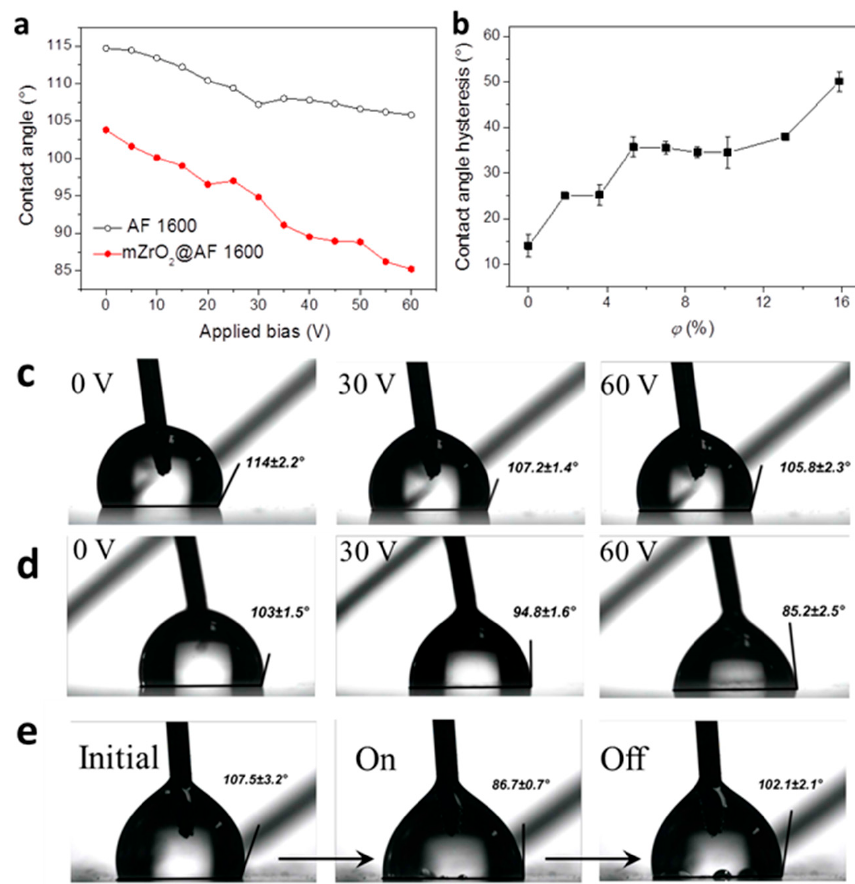
Figure 7. ( a ) Contact angles of the two films under applied DC electric field; ( b ) Contact angle hysteresis of the nanocomposite film with different mZrO 2 concentrations; ( c ) Contact angle images of the monolayer AF 1600 and ( d ) mZrO 2 @AF 1600 film at 0, 30 and 60 V, respectively; ( e ) Electrowetting reversibility of the sandwich structure.